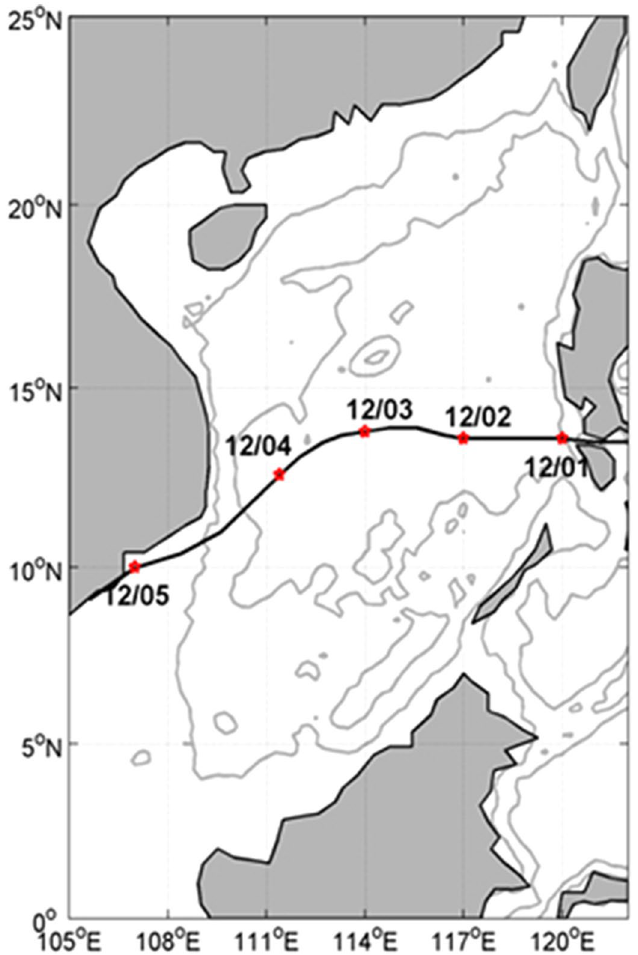
Figure 2. TY Durian’s track in the SCS (Red dots denote the location of the typhoon center at 0000